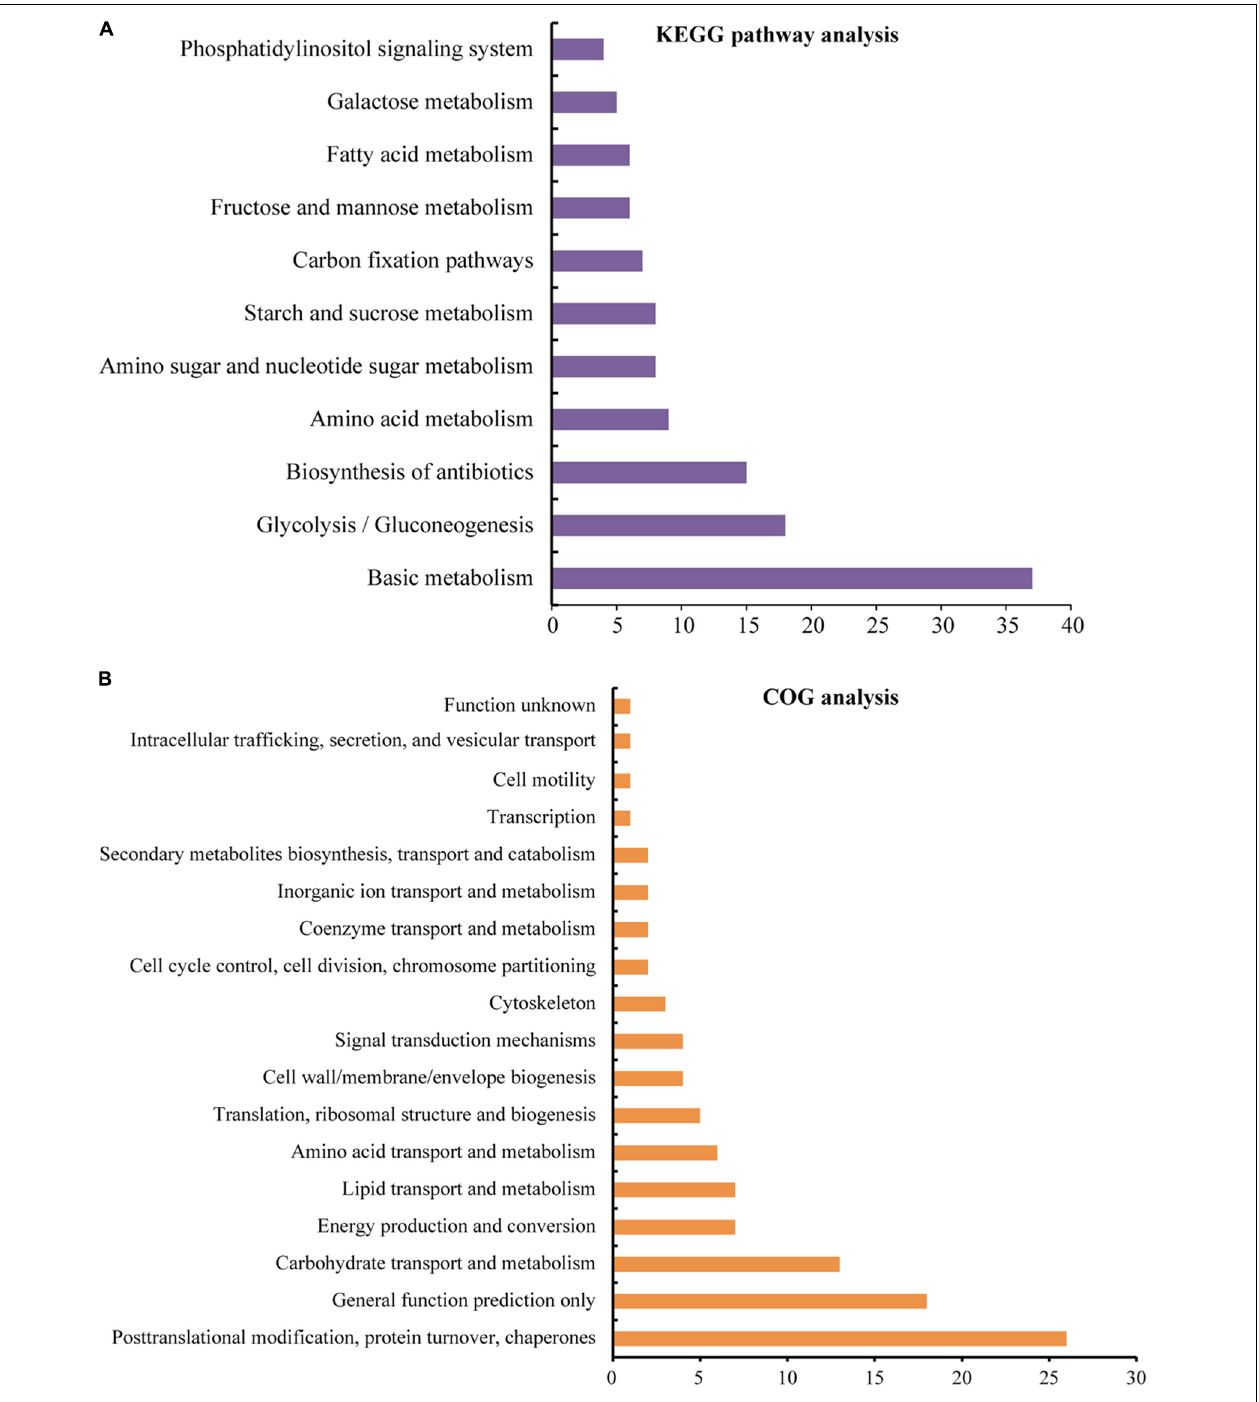
FIGURE 5 | KEGG pathway and COG functional analyses of the identified proteins. The sequence of the identified 114 unique DEPs was also analyzed by Blast2GO for KEGG pathways (A) analysis and performed by WebMGA to obtain COG functions (B) ; the e-value was 0.001. The detailed information is listed in Supplementary Table S2